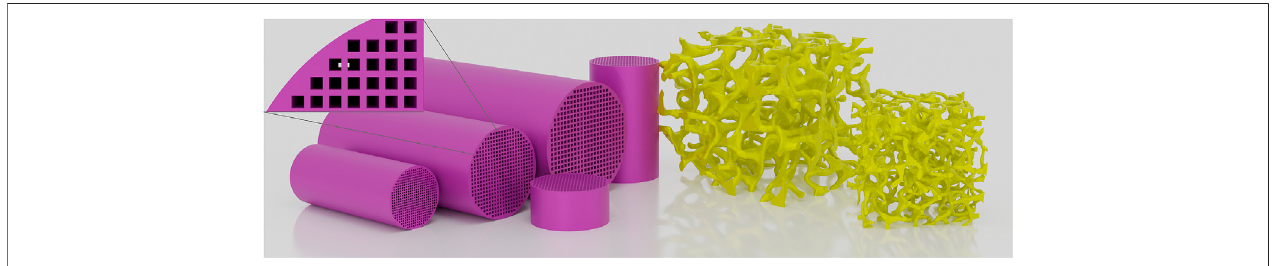
FIGURE3| Impressionoftwoconventionalcellularstructures;honeycombmonolithsinpurpleandfoamsinyellow.Thefoammodelisbasedona.stl fi leofMichael Chadband on gradcad.com.